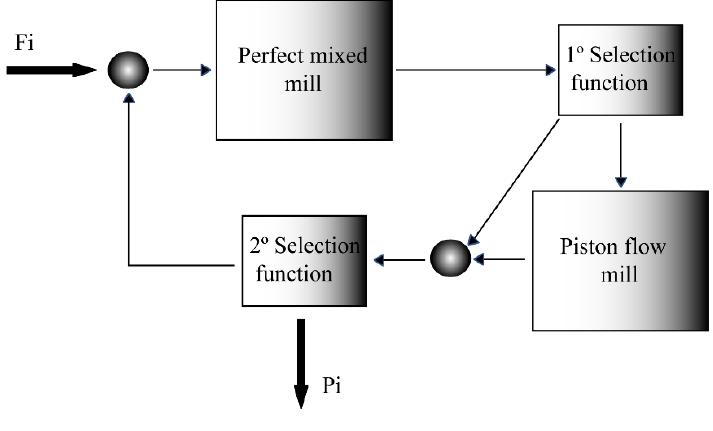
Table 4. Experimental design of the rod mill experiments for product control study. Vc is the critical rotational speed of the mill. The tests are grouped into six categories, where V changes Vc, M changes media charge percentage, S changes solid/liquid ratio, F changes solid feed flow, R changes rod diameter, and L changes lifter height.